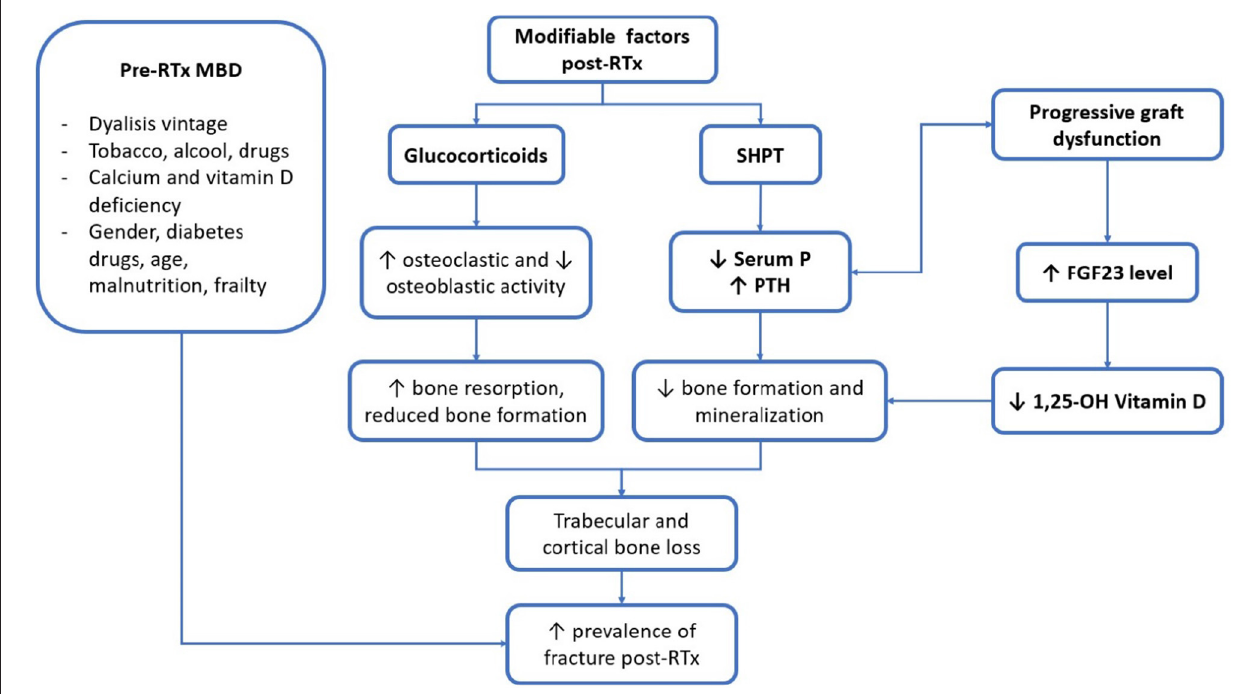
FIGURE 1 | Main clinical and biochemical factors of patients with renal transplantation (RTx-p) mineral metabolism. RTx, renal transplantation; SHPT, secondary hyperparathyroidism; P, phosphorus; PTH, parathormone; FGF23, fibroblast growth factor 23; 1, 25-OH vitamin D, 1, 25 hydroxylated vitamin